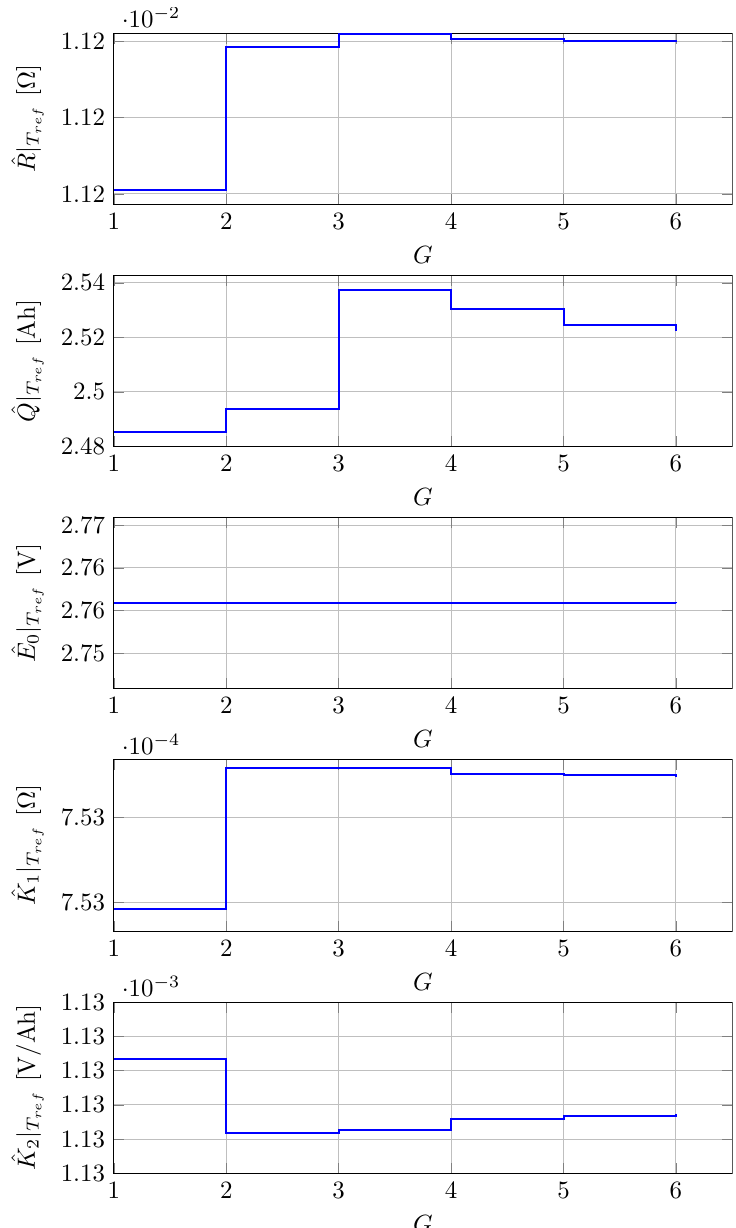
Figure 7. Estimated parameter values after the generation G . Figure 8 illustrates the deviation of the estimated voltage from the simulated voltage for the initial parameter set and after the first parameter estimation step. The objective of the parameter estimation is to reduce the difference between the simulated and the estimated battery voltages. At subsequent estimations this gap noticeably decreases while the solutions are improving, as it is seen in the bottom of Figure